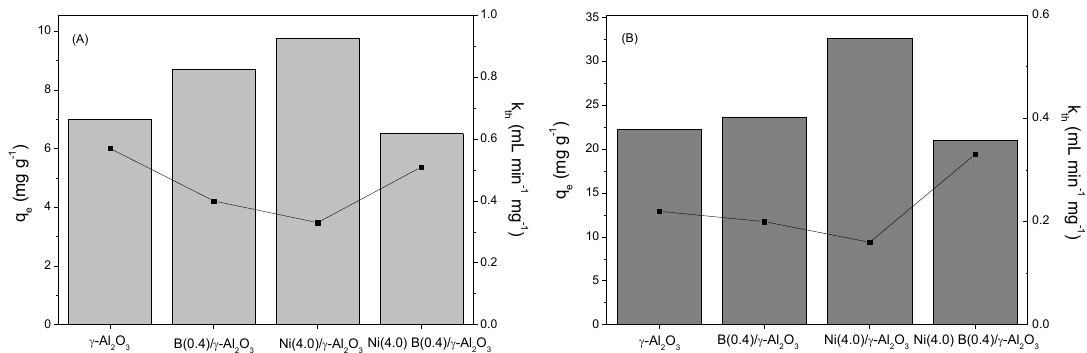
Figure 3. Adsorption capacities (bars) and Thomas kinetic constants (dots) obtained for the different adsorbents: ( A ) 4.6-DMDBT and ( B ) QN.